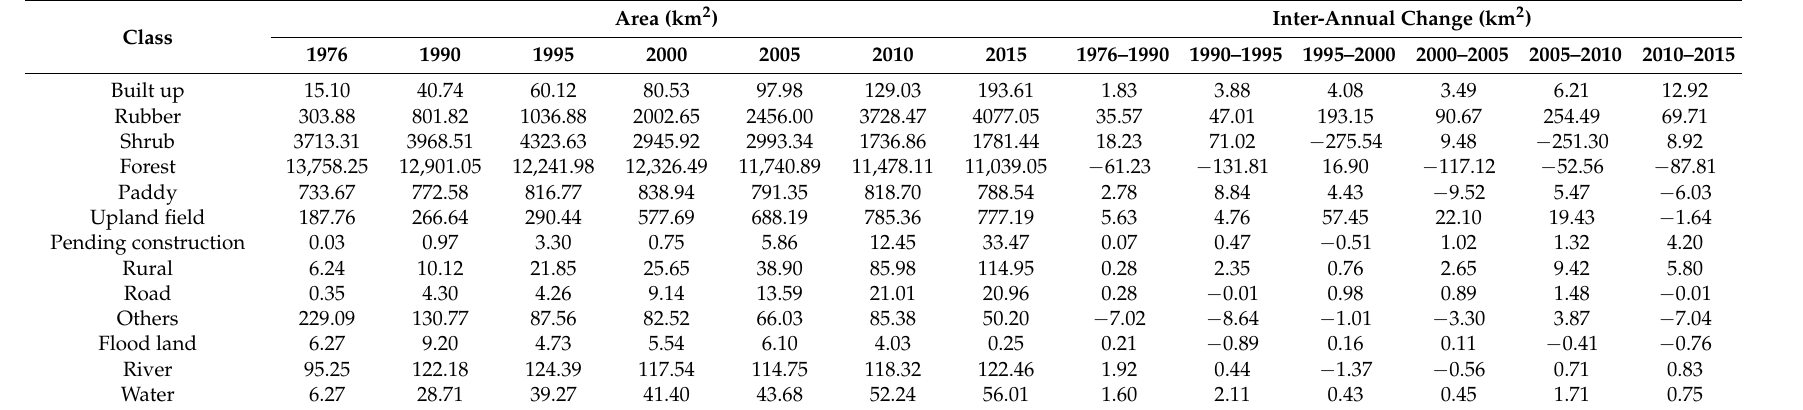
Table 3. Area and inter-annual change of land use from 1976 to